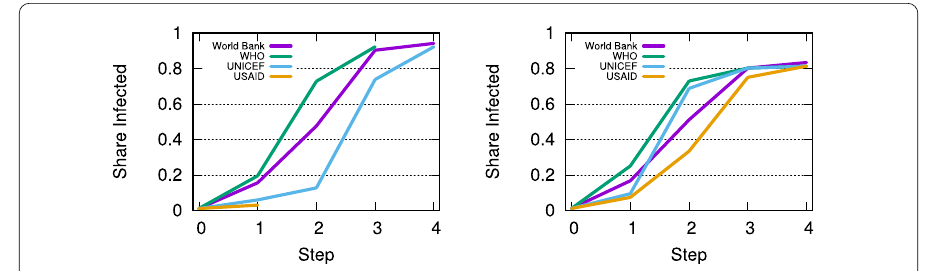
Figure 10 Different infection dynamics in the organization-organization citation network. The lines end when no further infections are recorded in the model. (Left) Infection dynamics for β = 0.1 for different organizations, aggregated to all keywords. (Right) Same as left, but only considering connections for the topic “Nurse”